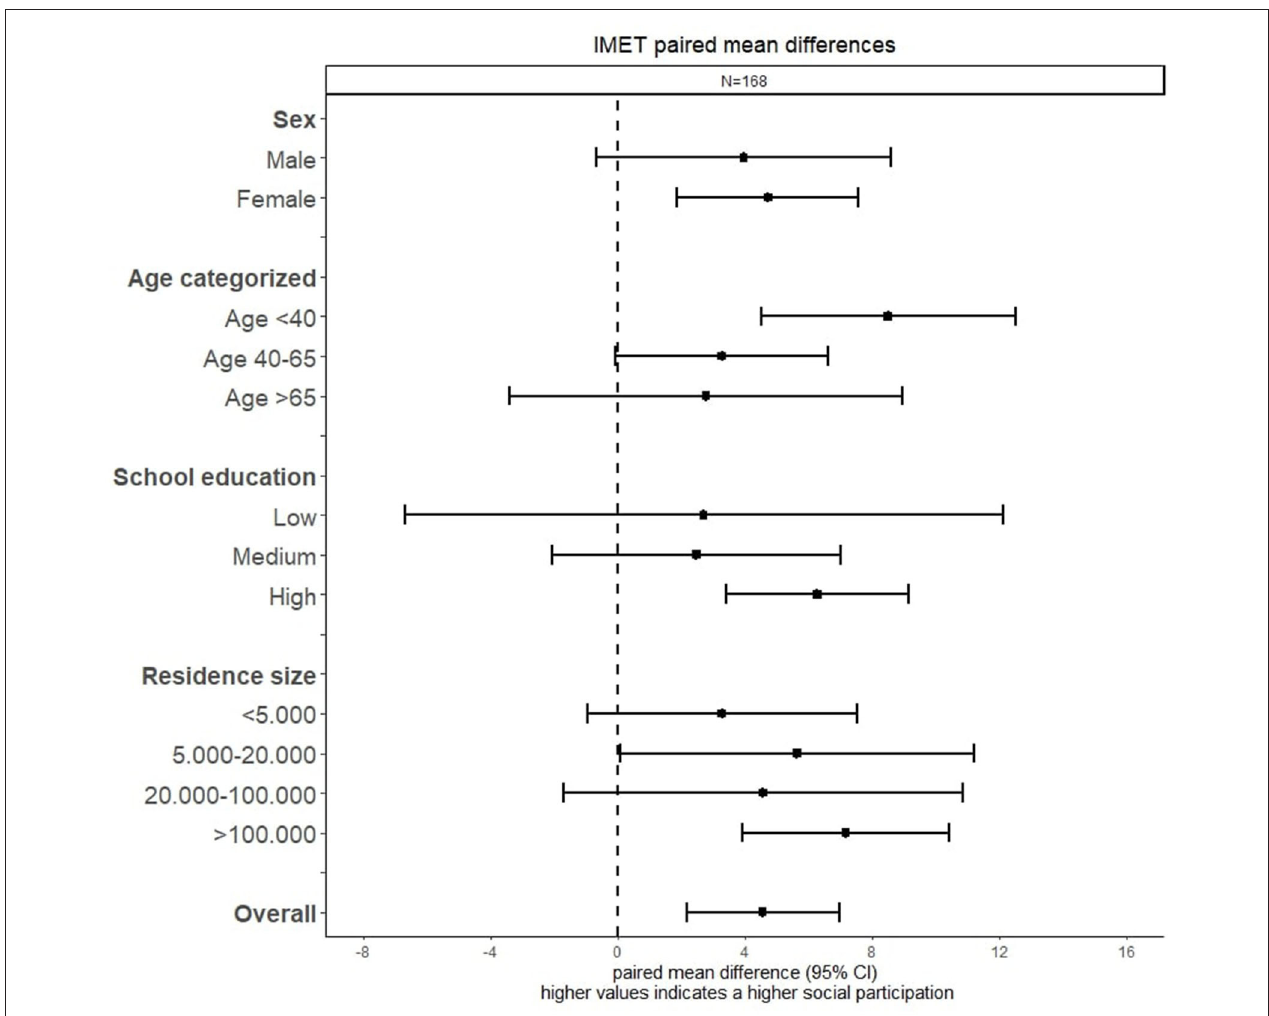
FIGURE 2 | Forest plot of the IMET paired mean difference across sociodemographic